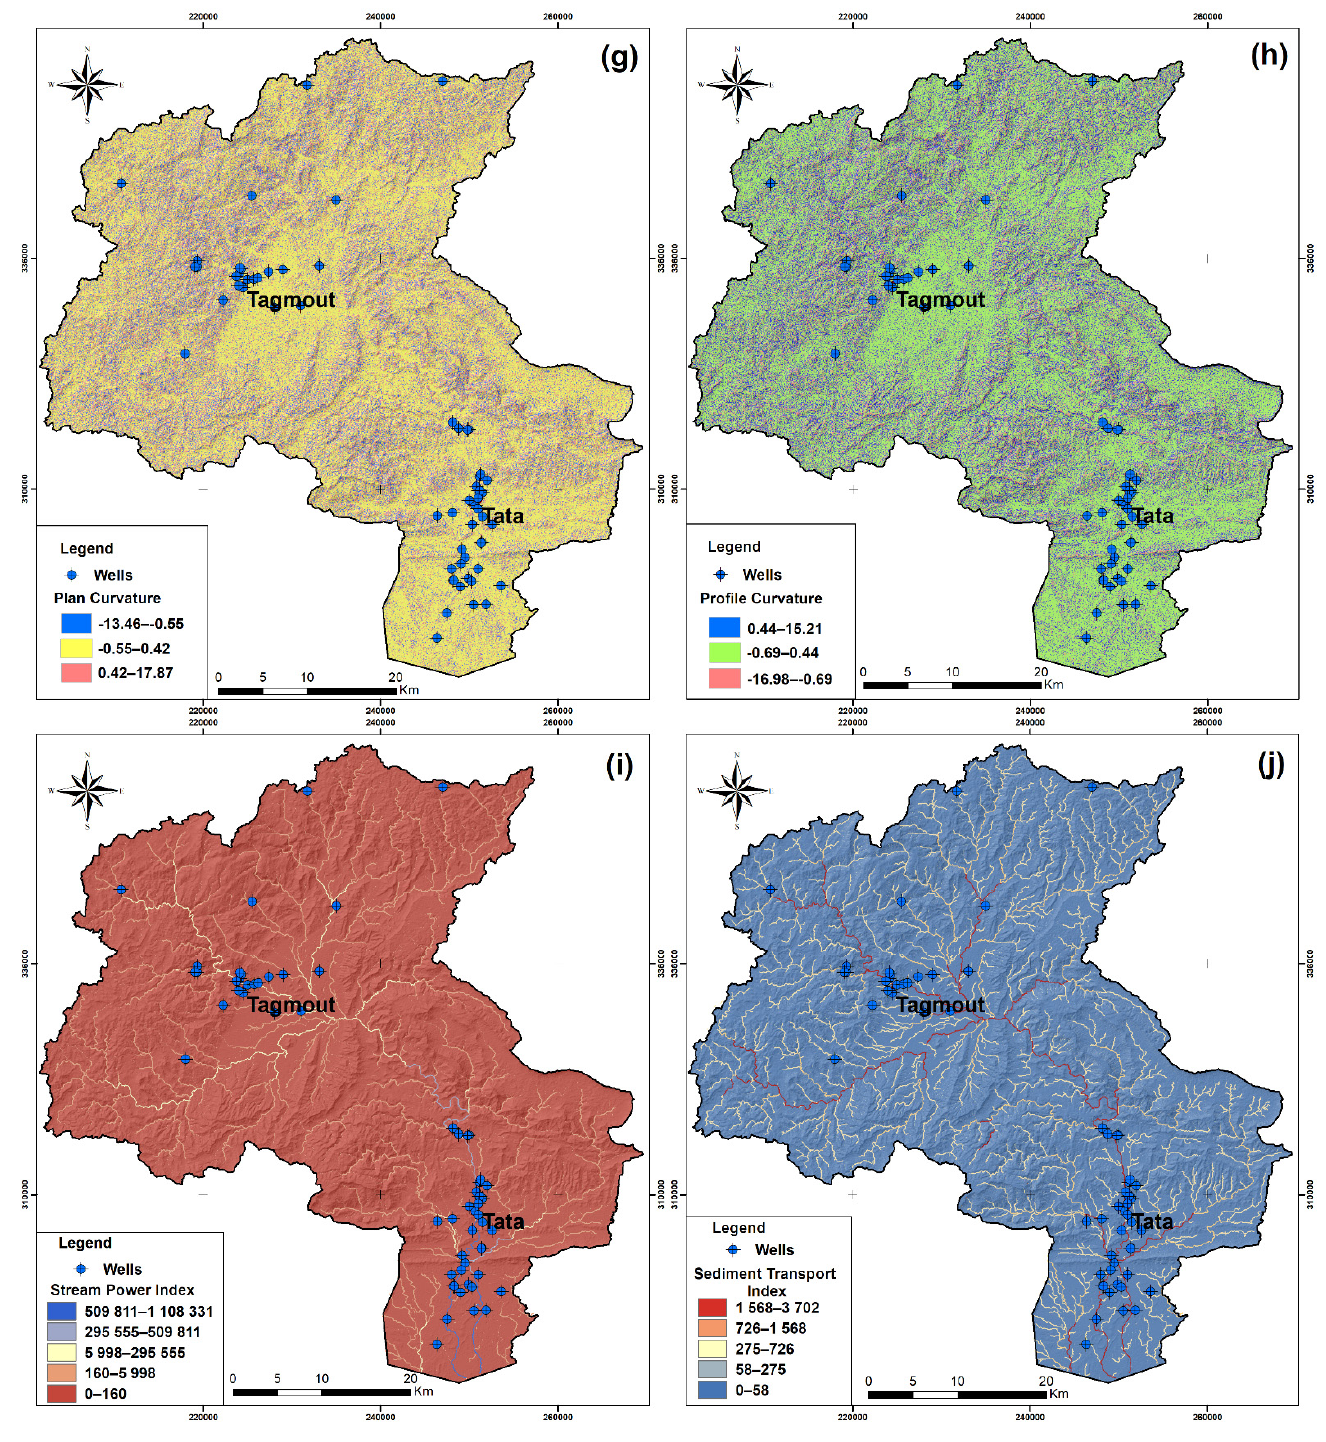
Figure 6. Variation maps of the factor influencing the groundwater potential map (part 2): ( g ) plan curvature (PLC); ( h ) profile curvature (PRC); ( i ) stream power index (SPI); and ( j ) sediment transport index (STI).